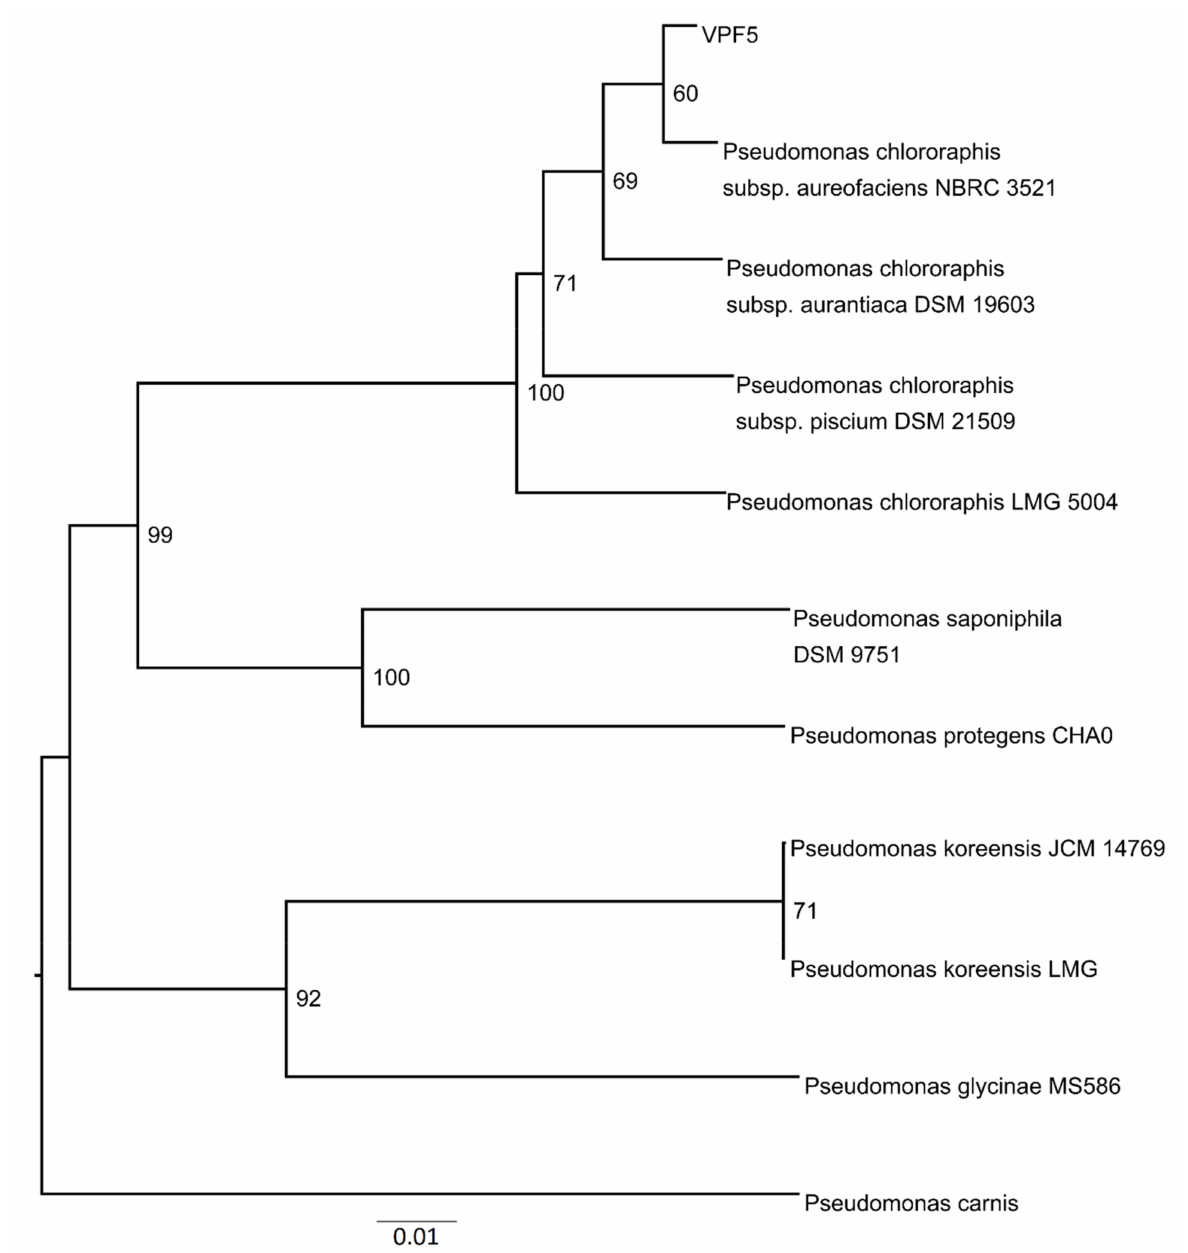
Figure 7. The distance-based phylogenomic tree based on the genomes of VPF506 and 10 Pseudomonas type strains retrieved from TYGS server (available at https://tygs.dsmz.de/, accessed on 20 January 2021). The tree was inferred using FastME2.1.6 [36] by calculating Genome BLAST Distance Phylogeny (GBDP) among selected genome sequences. The pseudo-bootstrap support value from 100 replicates is indicated per each internal node and the branch lengths are scaled using GBDP distance formula